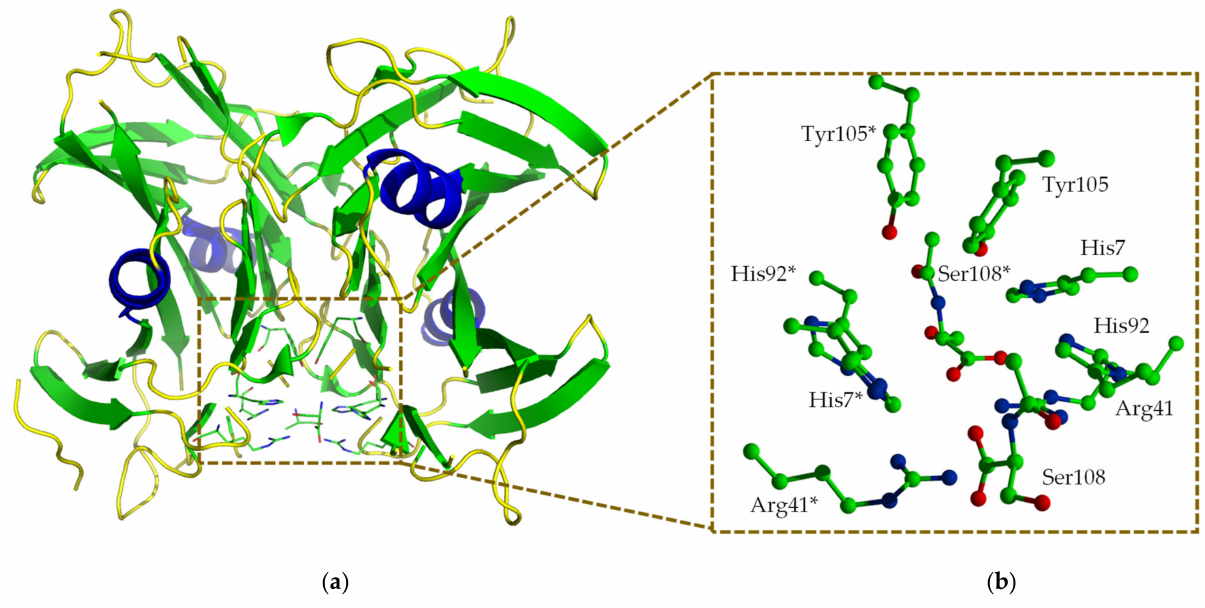
Figure 1. An overview of the X-ray structure of Klebsiella pneumonia 5-hydroxyisourate hydrolase ( kp HIUH). One of the active center is located at the interface between two protein chains ( a ). The residues in the active center are arranged in a two-fold symmetry ( b